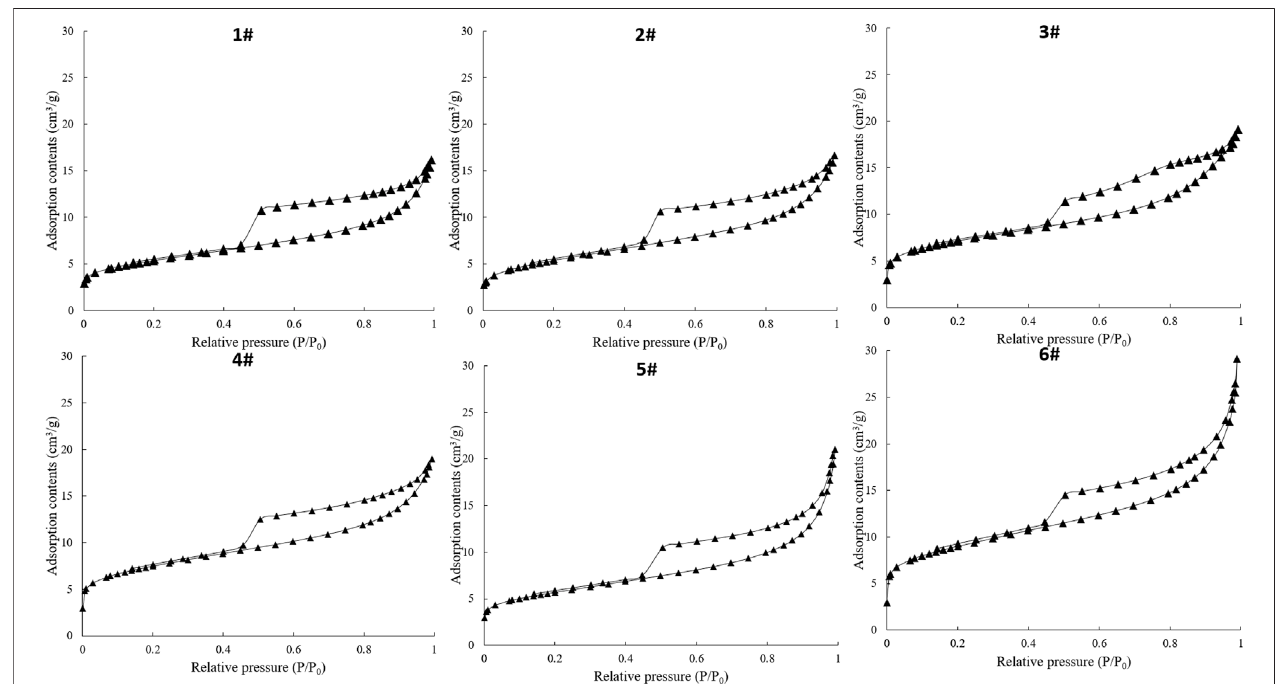
FIGURE 4 | N 2 adsorption/desorption isotherms of the various samples.